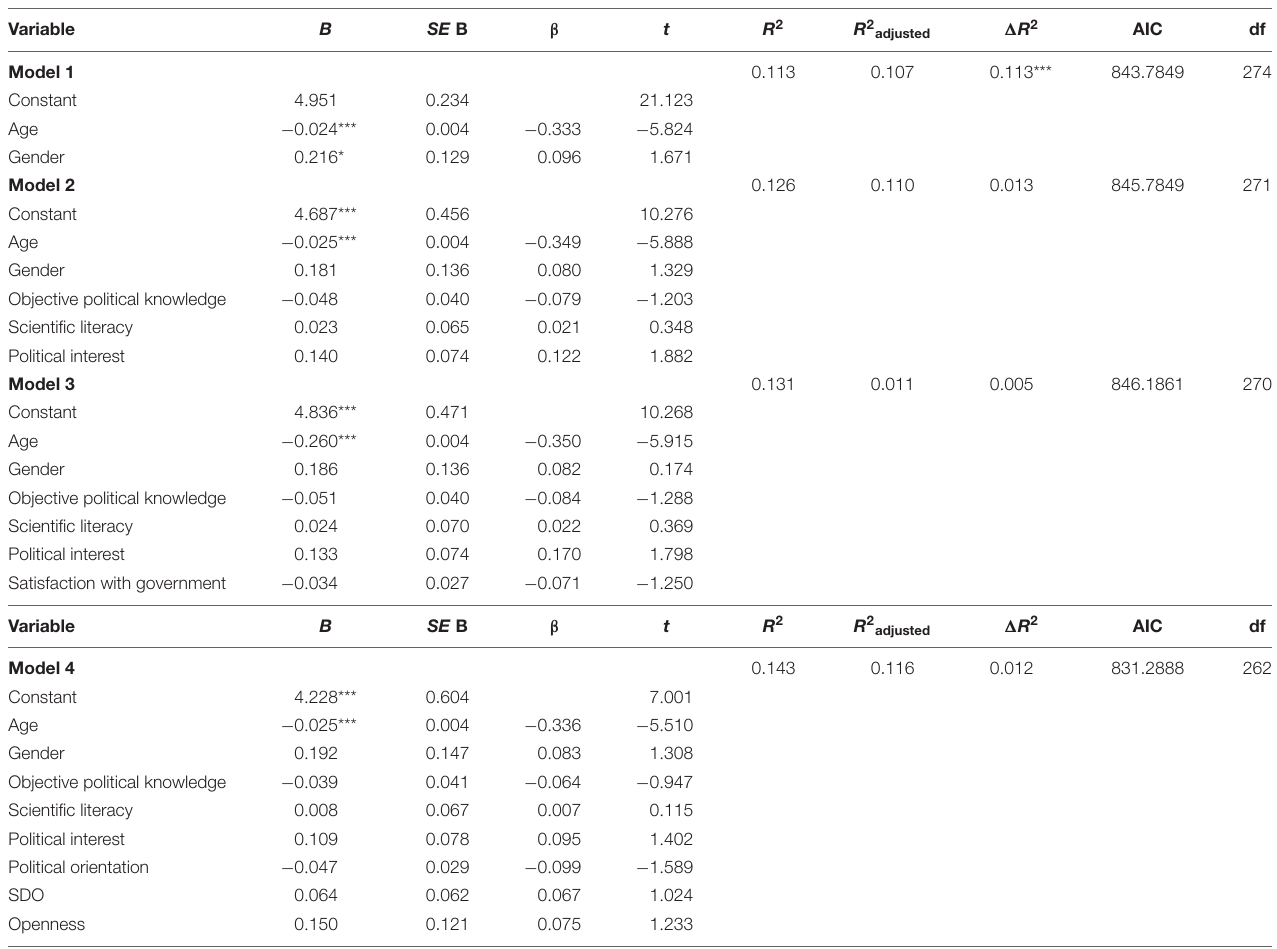
TABLE 5 | Hierarchical regression results for belief in non-political real